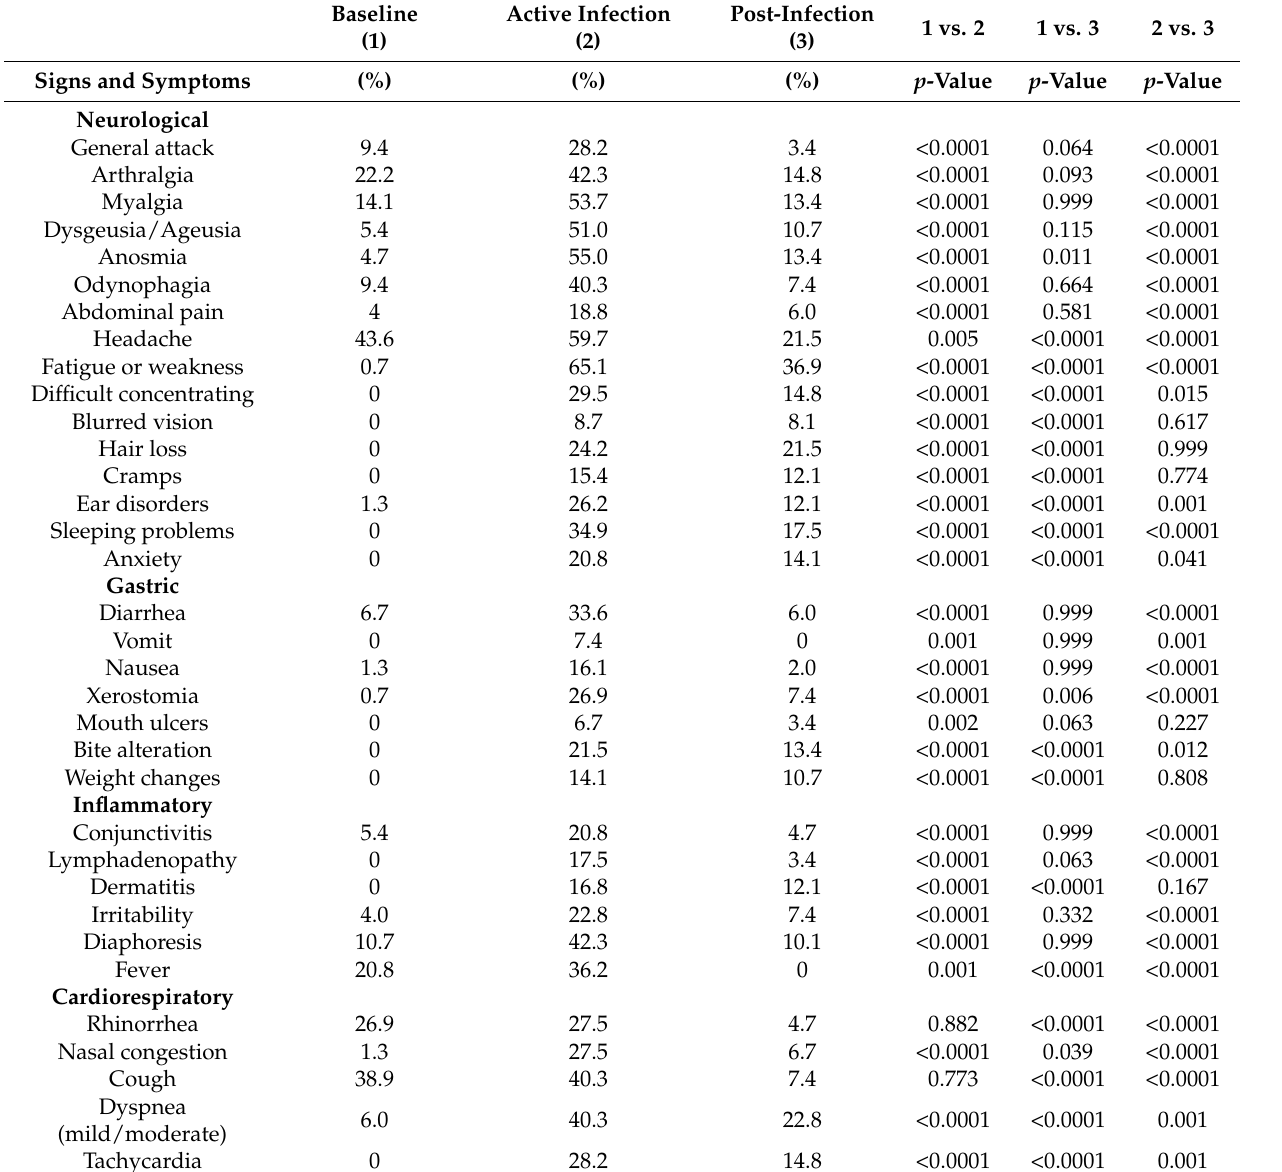
Table 2. Signs and symptoms prevalence in the study population ( n = 149) reported at baseline, in active infection, and during follow-up by six